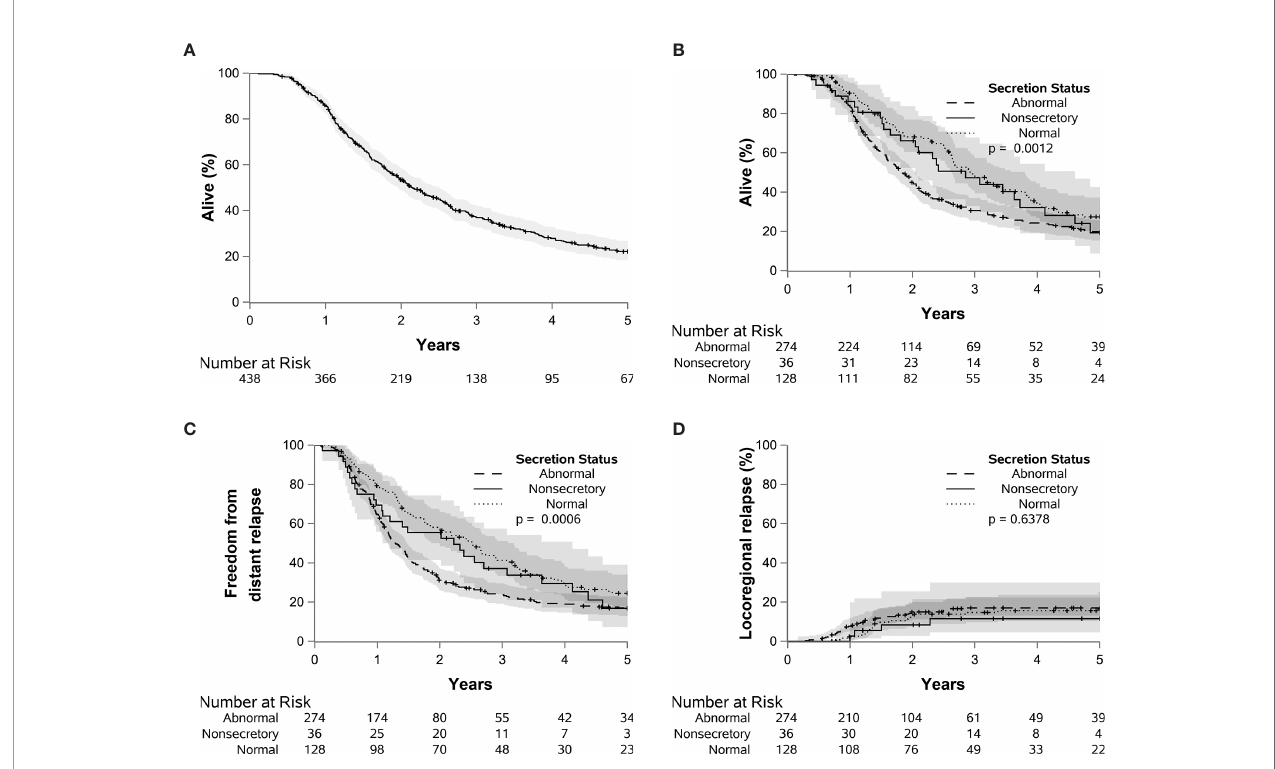
( Table 2 ). Increasing levels of CA 19-9 were correlated with